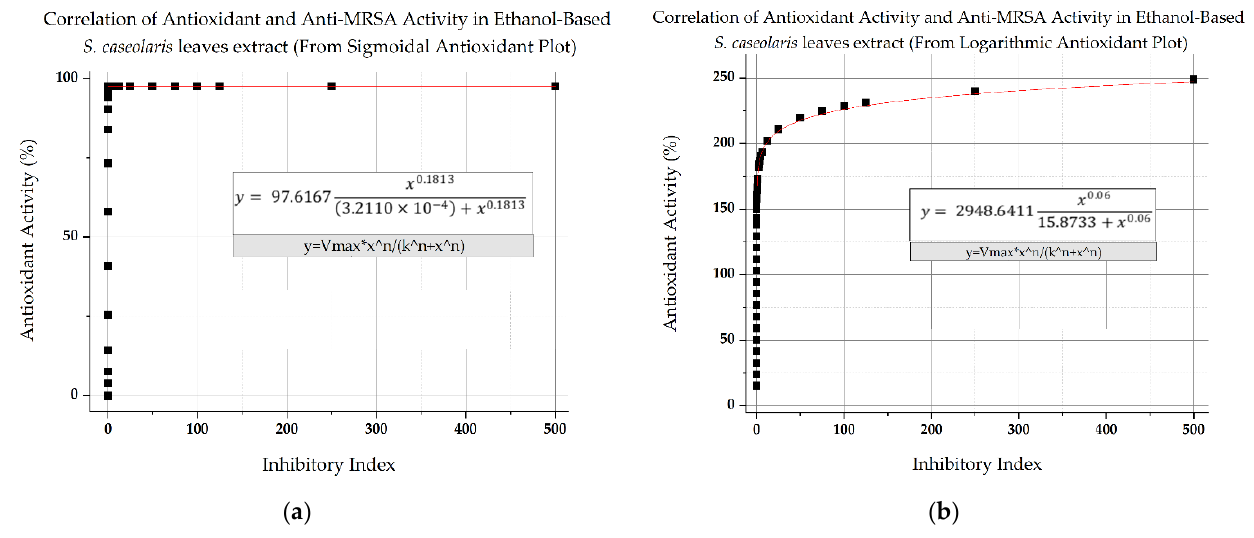
Figure 7. Correlation between antioxidant activity and antibacterial activity of ethanol-based S. caseolaris leaves crude extract against MRSA ( a ) using an antioxidant activity equation fitted in sigmoidal fitting and ( b ) in logarithmic fitting.